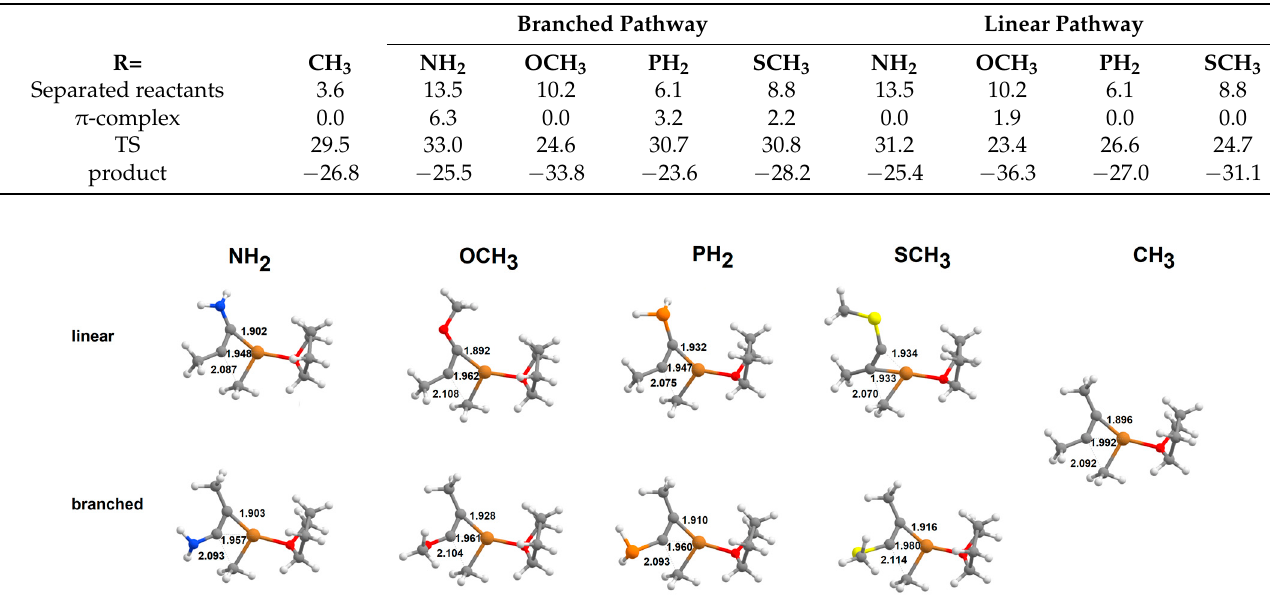
Figure 2. Transition state geometries for the methyl transfer from tetrahydrofuran-solvated CuCH 3 to alkynes of the form R-C ≡ C-CH